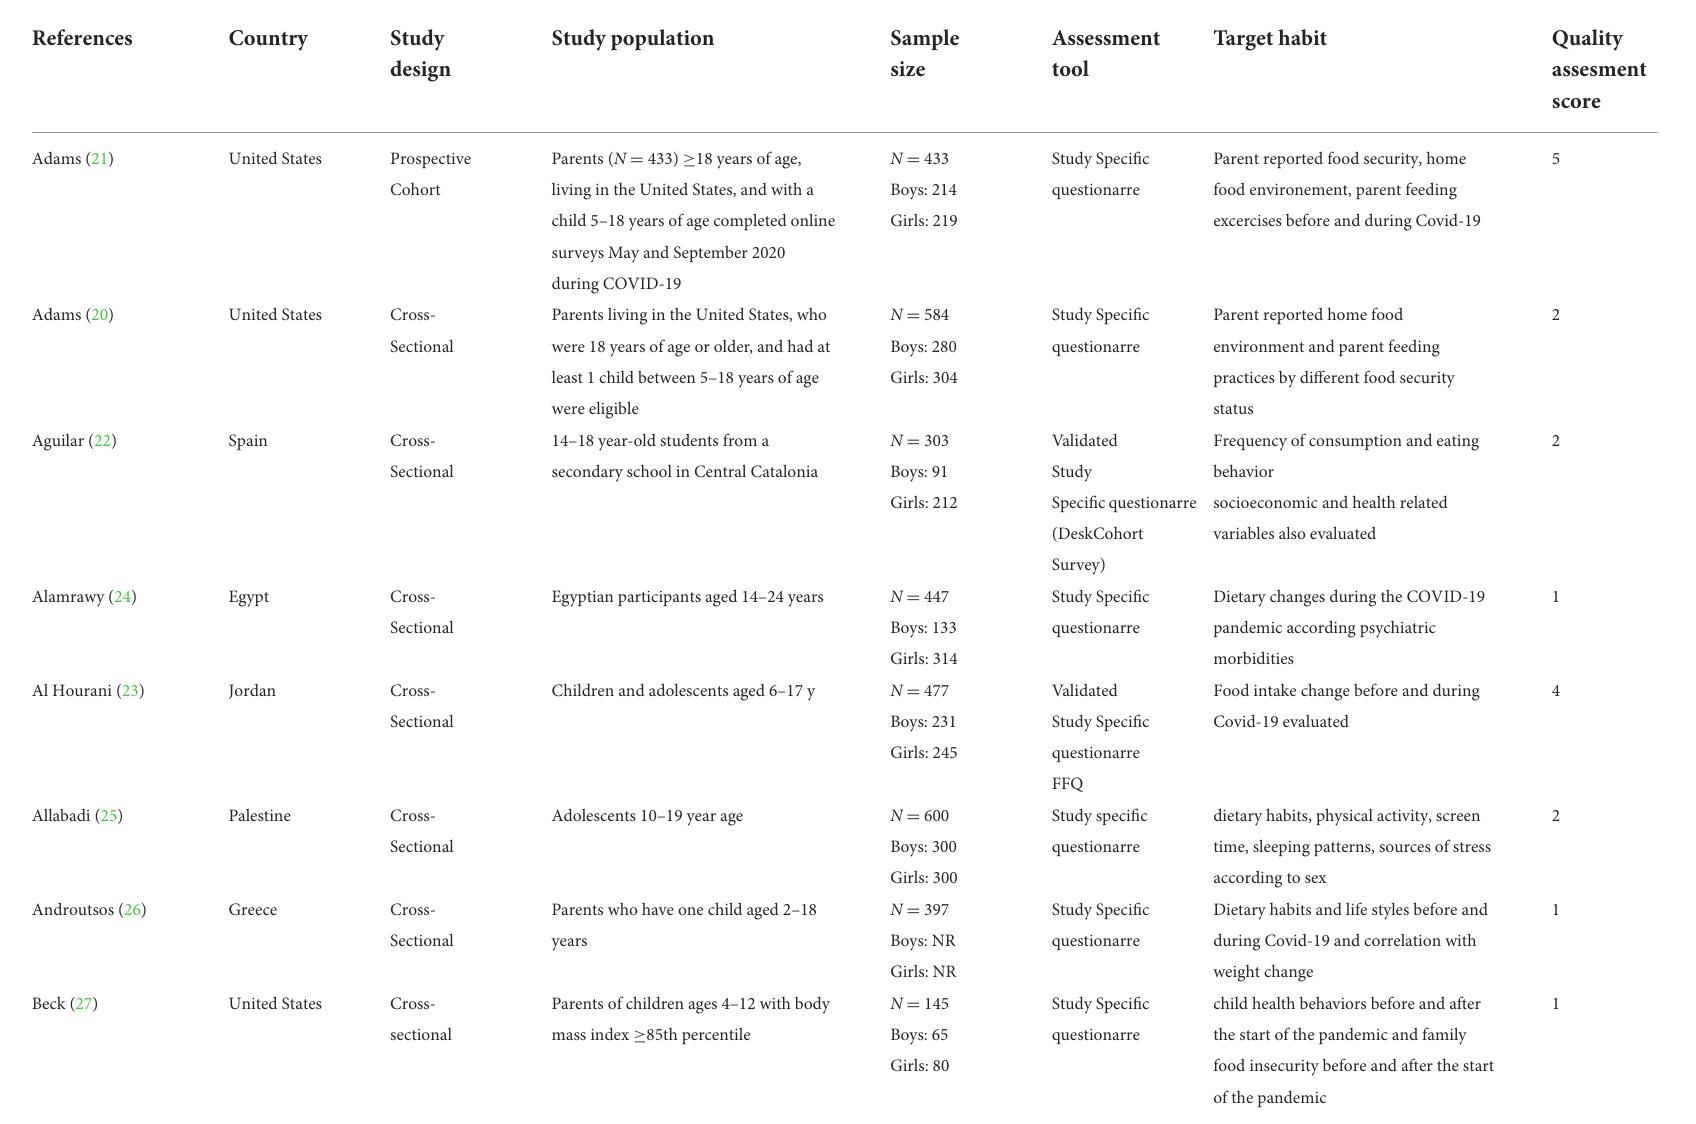
TABLE 1 General characteristics of included